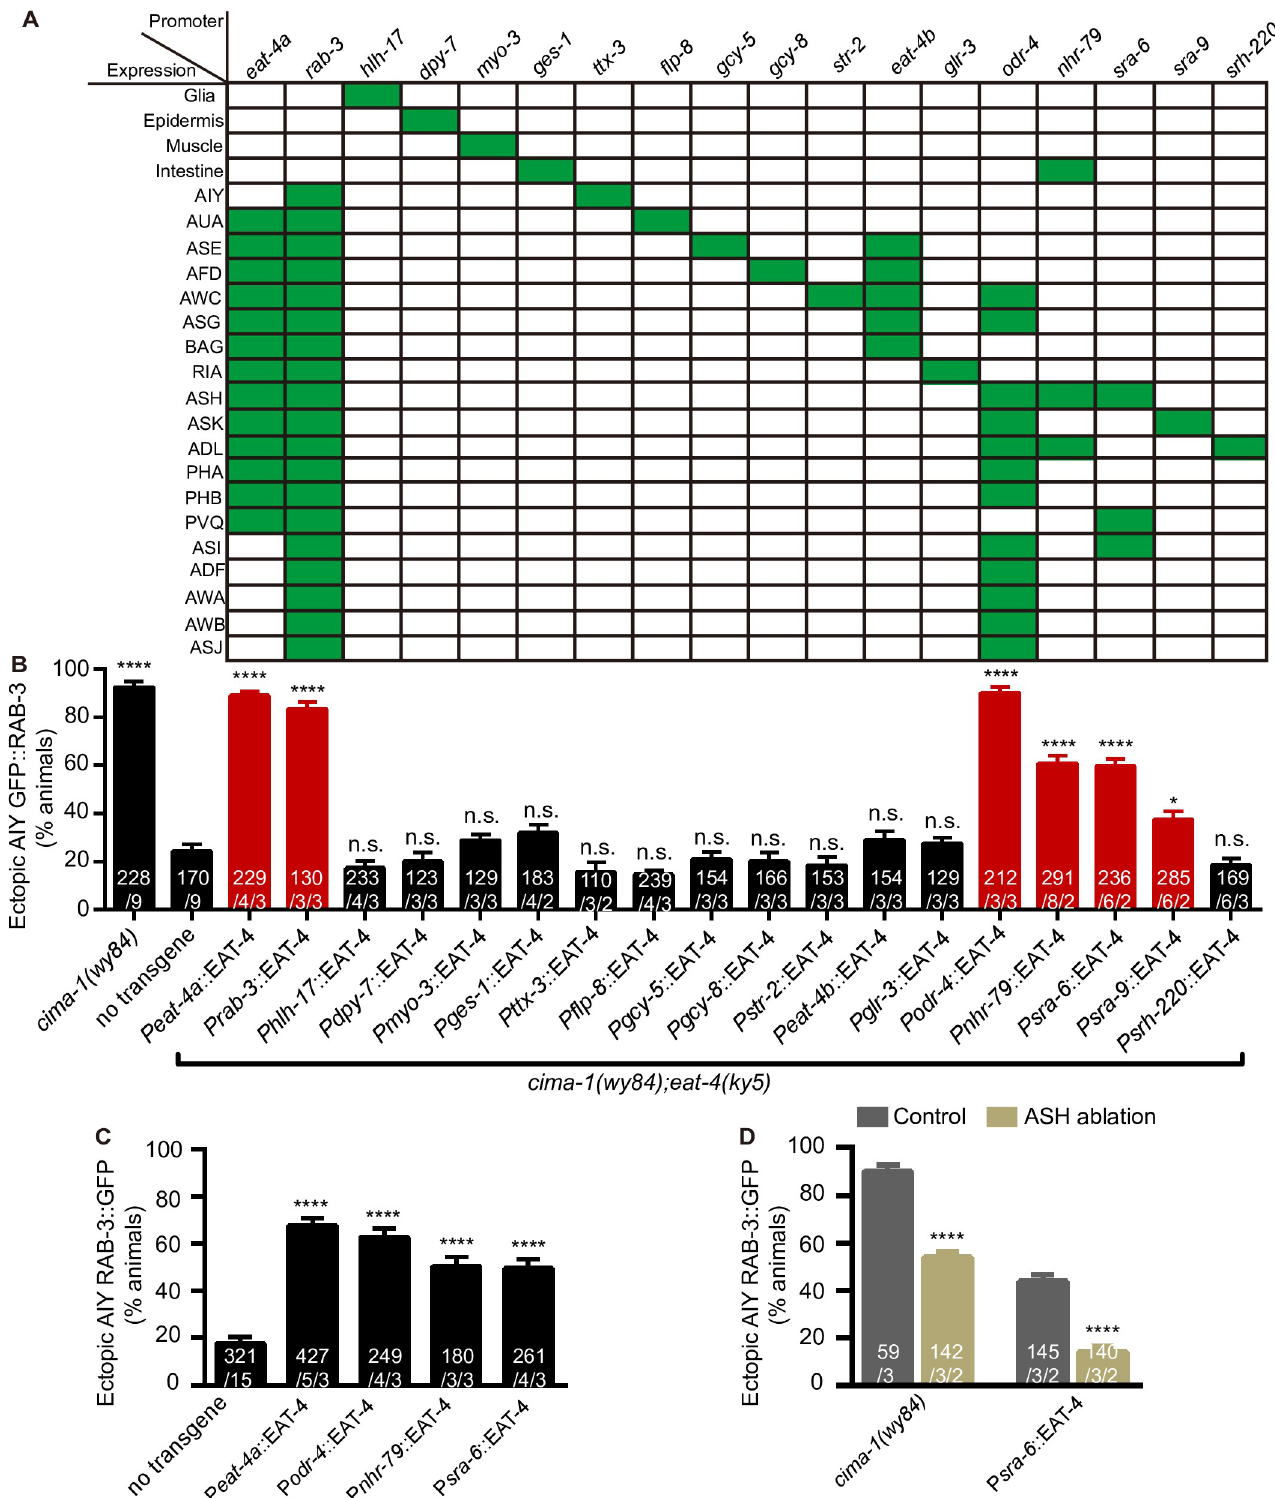
Fig 2. eat-4 acts mainly in the ASH to regulate the AIY synaptic subcellular specificity. (A) The tested tissue-specific promoters (first row) and the tissues/ neurons were listed in the table. Green boxes indicate the expressing tissues/neurons, while the empty boxes indicate the non-expressing ones. Note that the neurons expressing eat-4 cDNA through eat-4a or rab-3 promoter include but are not limited to those listed in the table. (B-D) Quantification of the percentage